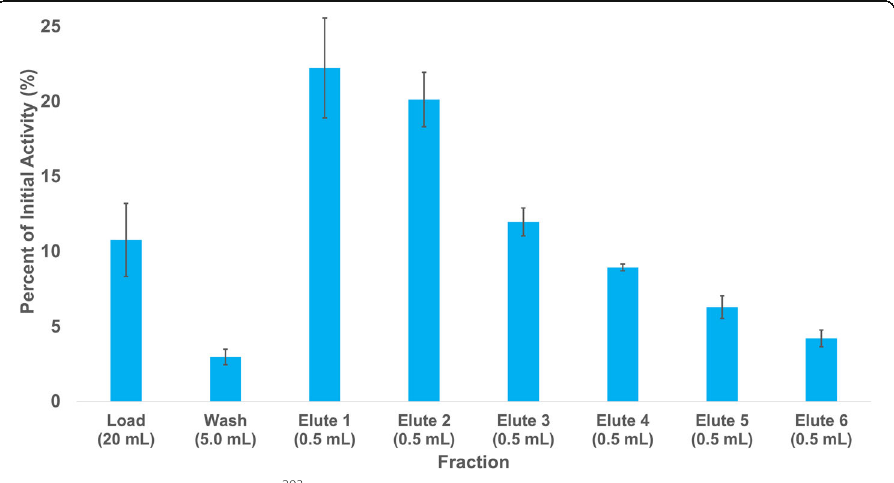
Fig. 6 Average elution profile for 203 Pb purification from Pb resin using NH 4 OAc (1 M, pH 7) ( n =